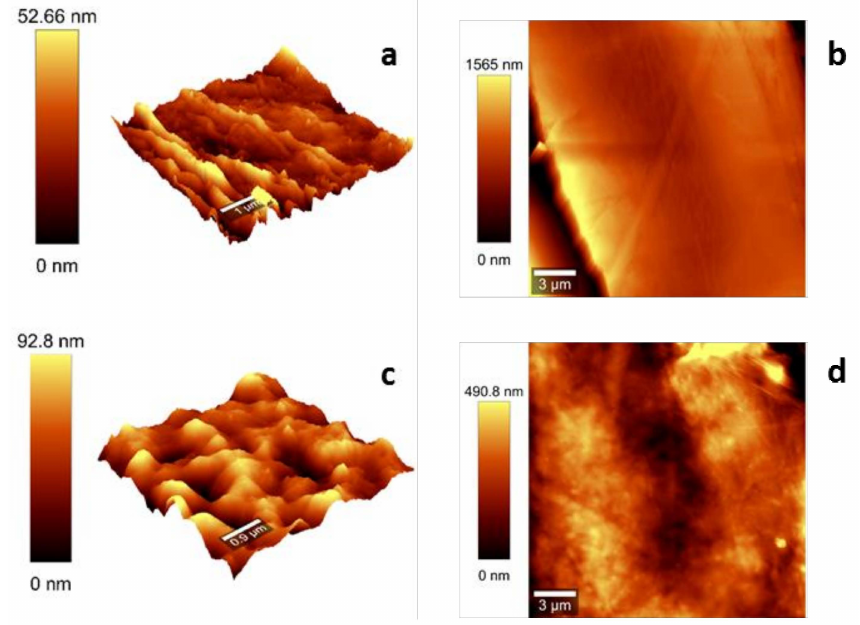
Figure 5. The 3D ( a , c ) and 2D ( b , d ) AFM surface topology images of uncoated ( a , b ) and (CL + LS) coated handsheet ( c , d ). Table 2. Water contact angles of handsheets subjected to different lignin coating assembles. * Coating